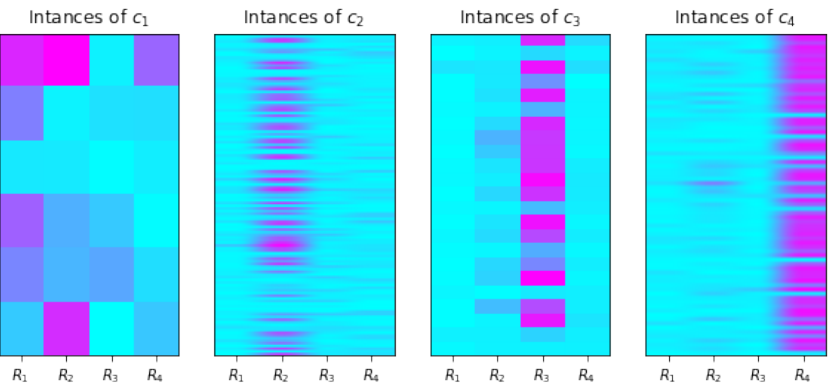
Figure A2. Heatmaps of the absolute attention scores for each MC instance in TACRED training dataset over value vectors of reference sentences. The Y -axis represents an instance, the X -axis represents a reference sentence, and the value is the reliability score. The expected heat map of the ideal dataset and MCAM is showing a high value (almost purple) on the i -th column of the i -th figure where the scores of the c i instances are